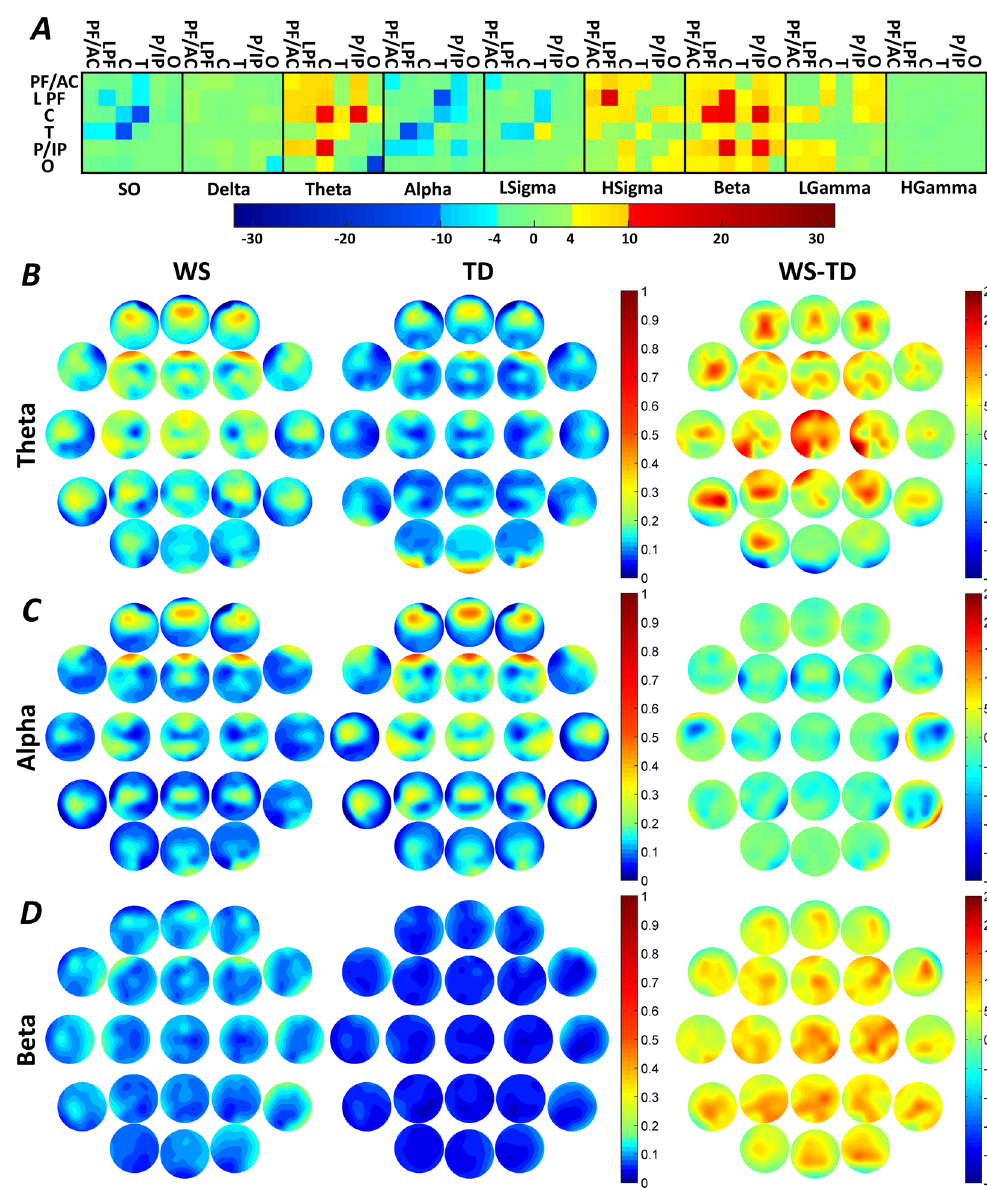
Supplementary Table S11). Increased intrahemispheric as compared to interhemispheric connectivity (F = 25.46; d.f. = 2, 76; p < 0.0001), increased broadband-1 as compared to broadband-2 WPLI (F = 49.30; d.f. = 1, 38; p < 0.0001), as well as unequal Intra/inter hemispheric connection differences in the two bands (F = 13.24; d.f. = 2, 76; p < 0.0001) were seen in both groups (Williams syndrome, typically developing).